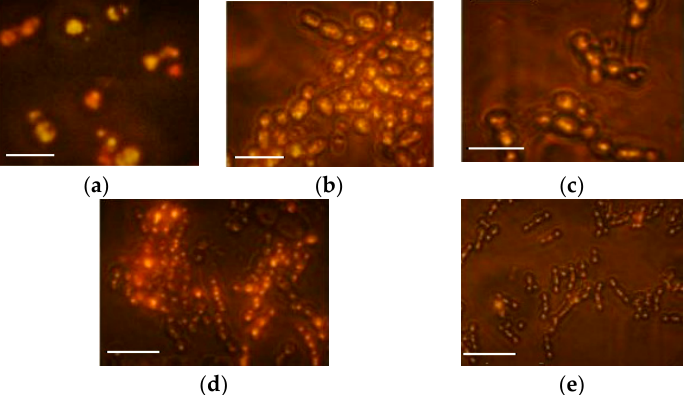
Figure 3. Microscopic examination of yeast cells stained with Nile red fluorescence dye. Yeast cells were grown in a shaken flask under different Al 2 (SO 4 ) 3 concentrations using the optimized medium as a control, with C/N equal to 146 (using ammonium sulfate as a sole nitrogen source) and C/S equal to 120, at 180 rpm and at 28 °C for six days. ( a ) Control. The Al 2 (SO 4 ) 3 concentrations were ( b ) 0.1 mM, ( c ) 0.3 mM, ( d ) 0.7 mM, and ( e ) 1 mM. The magnification bar is equal to 10 µm.